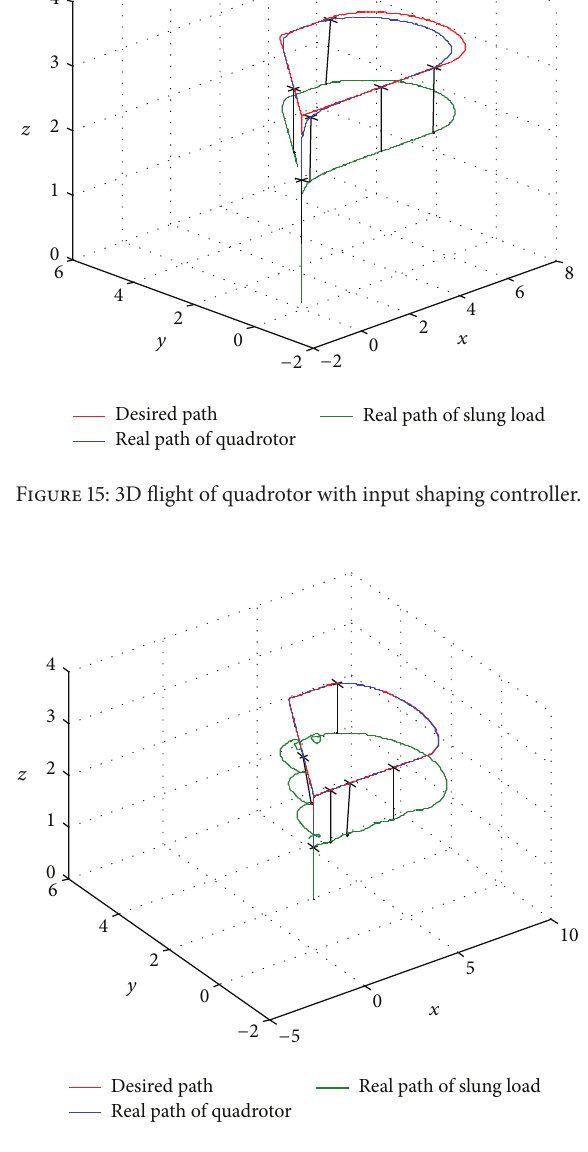
Figure 16: 3D flight of quadrotor without input shaping controller.